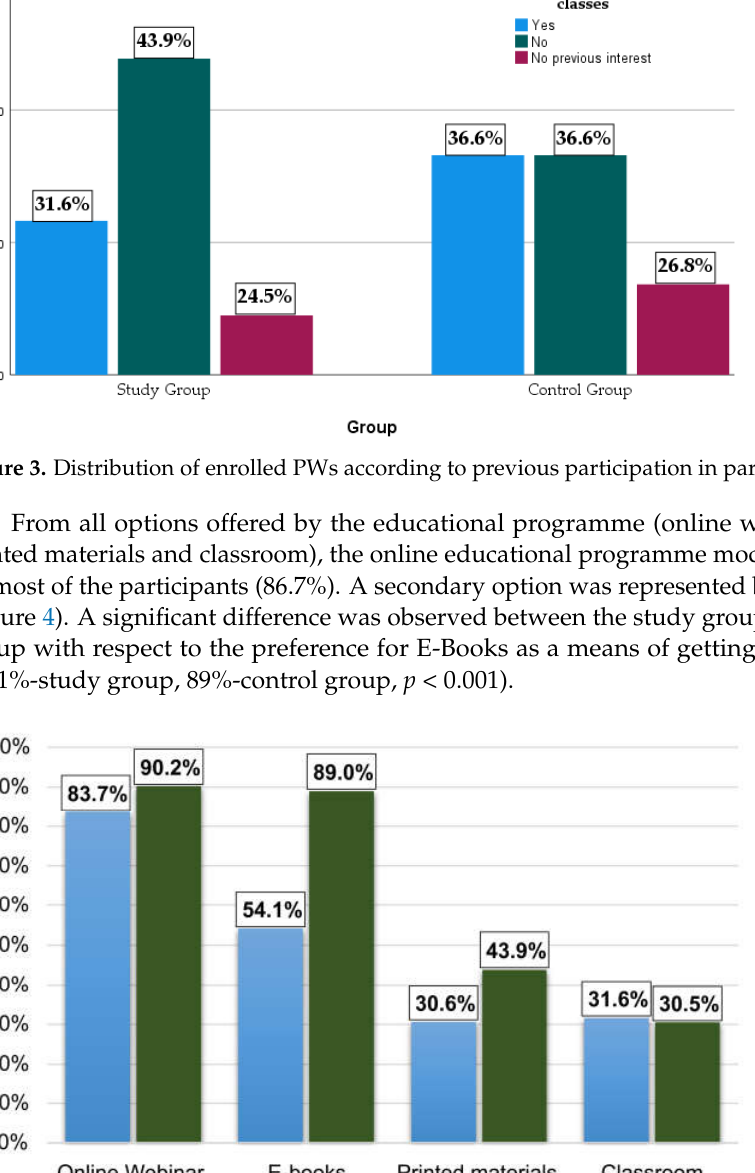
( b ) Figure 2. ( a ) Distribution according to the age of the PWs; ( b ) distribution according to gestational age. For the enrolled PWs, we evaluated the degree of acceptance regarding their vaccina-